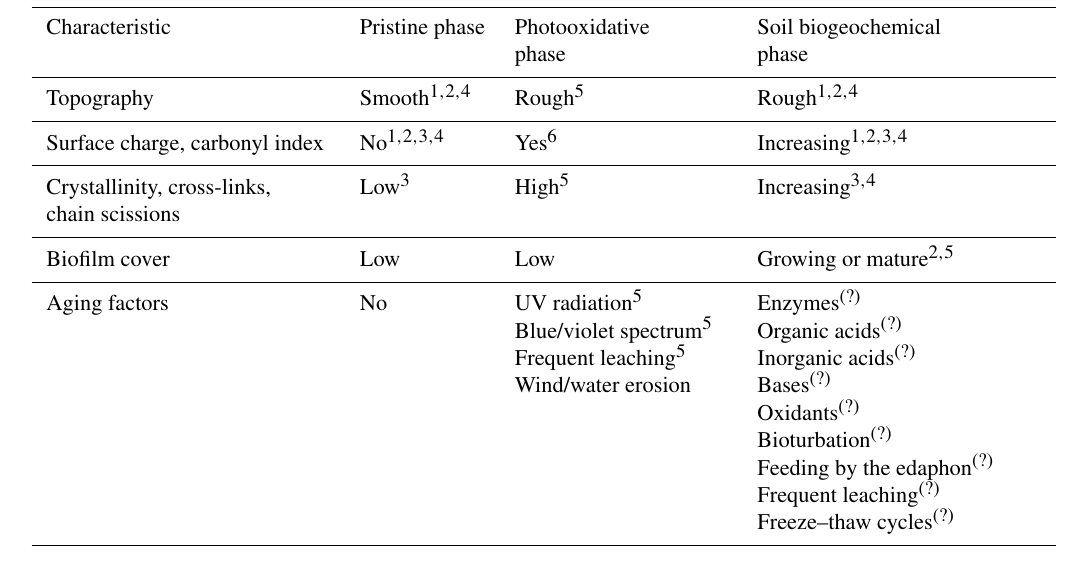
Table 1. Development of surface characteristics during the three phases of aging (pristine, photooxidative, and soil biogeochemical phase). Data of soil biogeochemical weathering are only known from aquatic systems. The question mark (?) indicates assumptions based on soil biogeochemical processes found in soils. Some references are from 1 Fotopoulou and Karapanagioti (2012), 2 Fotopoulou and Karapanagi-